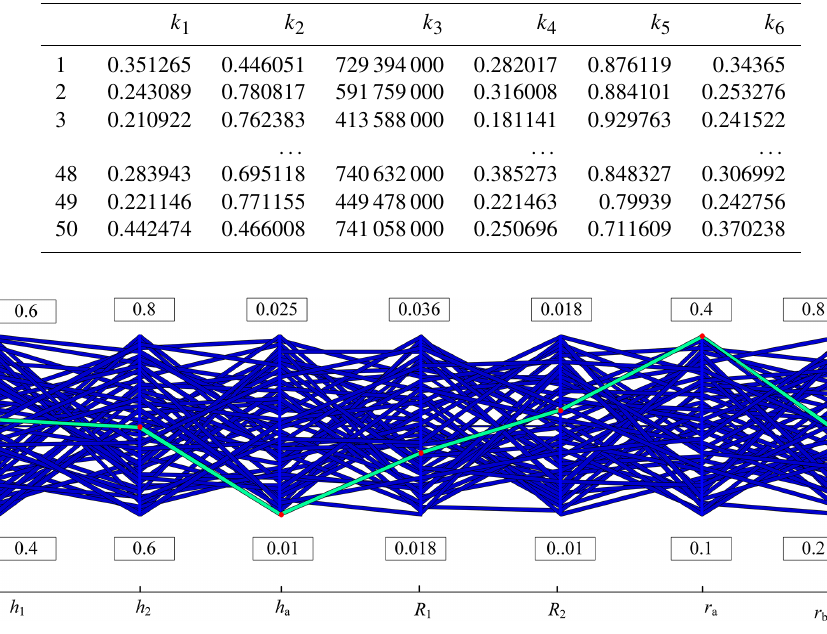
Figure 3. Parametric design variable combination